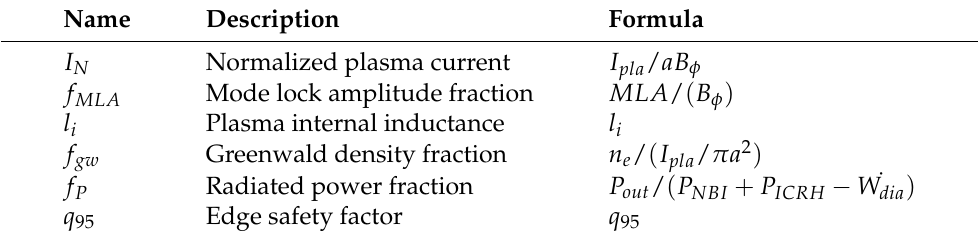
Table 2. List of machine independent features that are used to train the dimensionless predictors and how they are derived from the original set of features in Table